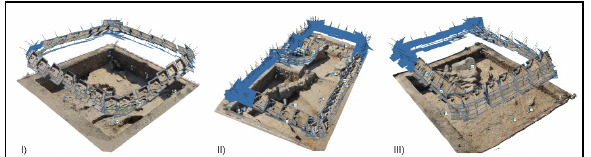
Figure 10 . Overview of the GCPs and the terrestrial image data (DSLR Canon EOS 1200D, 19/7/2019) after the image orientation in AgiSoft PhotoScan software of the: (I) first, (II) second and third, (III) forth archaeological